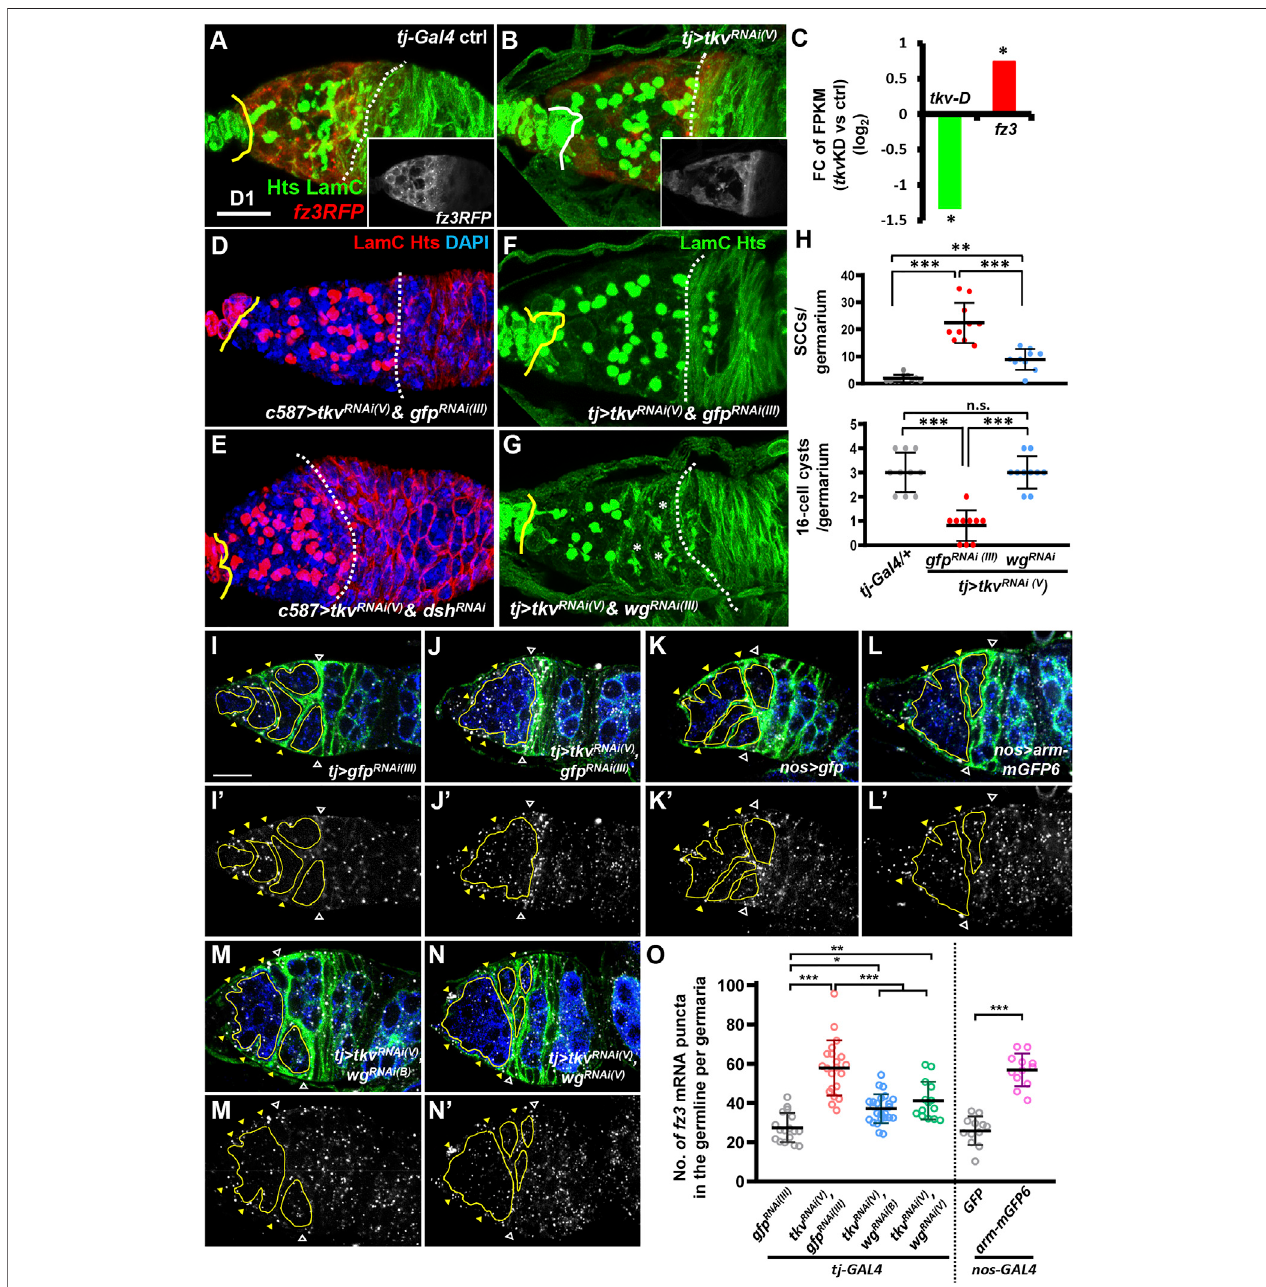
FIGURE 4 | Wg signaling is activated in the germ cells of somatic-tkv knockdown germaria. (A and B) tj-GAL4/+ (A) and tj > tkv RNAi (V) germaria (B) with LamC (green, TF and cap cell nuclear envelopes), Hts (green, fusomes) and fz3RLFP (red, canonical Wnt signaling reporter). Insets in A and B show only fz3RFP channel. (C) Fold-change (FC) of RNA-seq based gene expression values (log2) for tkv transcript variant D ( tkv-D ) and fz3 in 1-day (D) -old control (ctrl, UAS-tkv RNAi (N) /+ ) and c587 > tkv RNAi(N) anteriorovariolescomparedwith UAS-tkv RNAi(N) /+ (control, ctrl).FPKM,fragmentsperkilobaseoftranscript permillionmappedreads. *, p < 0.05. Statisticalanalysiswasperformedwithtwobiologicalreplicates. (D to G) c587 > tkv RNAi(V) &gfp RNAi(III) (D) , c587 > tkv RNAi(V) &dsh RNAi (E) , tj > tkv RNAi(V) &gfp RNAi(III) (F) and c587 > tkv RNAi(V) & wg RNAi germaria (G) with LamC (red in D and E, green in F and G), Hts (red in D and E, green in F and G) and DAPI (blue, DNA, in D and E). Yellow lines denote the junction between cap cell and GSC; dashed line mark the 2A/2B boundary or the junction between escort cells and follicles when the 2A/B boundary is missing. Asterisks mark 16-cell cysts. (H) Numbers of spectrosome-containing cells (SCCs) and 16-cell cysts per germarium of fl ies with the indicated genotypes. (I – N) In situ hybridized tj > gfp RNAi (III) (I) , tj > tkv RNAi (V) & gfp RNAi (III) (J) , tj > gfp (K) , tj > arm-mGFP6 (L) , tj > tkv RNAi (V) & wg RNAi(V) (M) and tj > tkv RNAi (V) & wg RNAi(B) germaria (N) with labeling for Fax (green, escort cell membrane extension), Vasa-GFP (blue, germ cells), and fz3 mRNA (gray). (I ’ – N ’ ) show the fz3 channel. Hollow triangles point to the 2A/B boundary;yellow triangles indicate escort cell region; germ cell regions before the 2A/B boundary are outlined byyellow circles. (O) Number (No.) of fz3 mRNA puncta inthegermlineper germariumwith theindicatedgenotypes. *, p < 0.05, **, p < 0.01; ***, p < 0.001. Errorbars indicate mean ±S.D.,One-Way ANOVA wasused for statistical analysis. RNAi was expressed throughout development. Scale bar, 10 μ m. A and B, D-G, and I to N are 3D-reconstructed images.